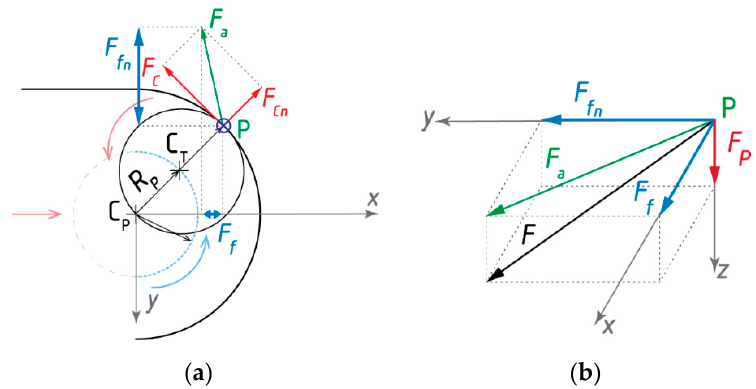
Figure 5. Scheme of the components for total machining force F : in 2D-plan ( a ) and 3D-side ( b ) views.